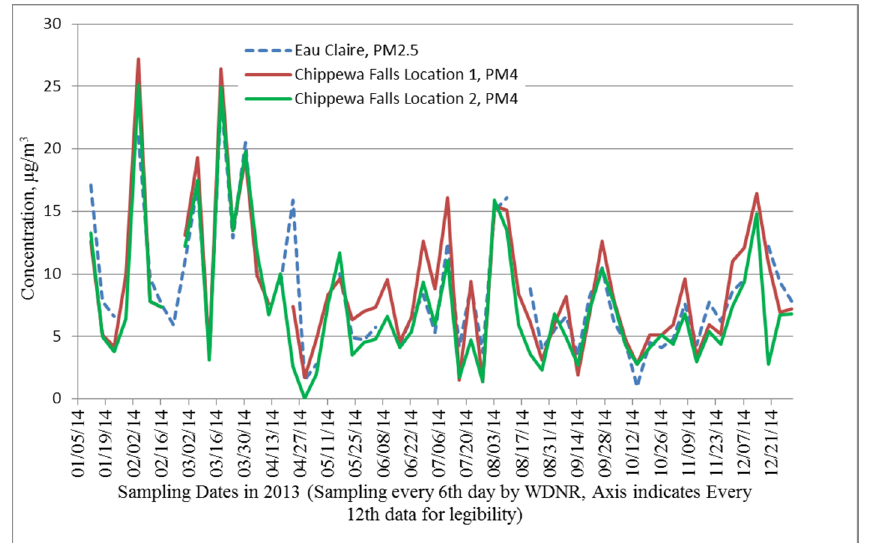
Figure 13. Comparison of the WDNR PM2.5 data from Eau Claire with the PM4 particulate matter data from Chippewa Falls Locations 1 and 2, January 2014–December